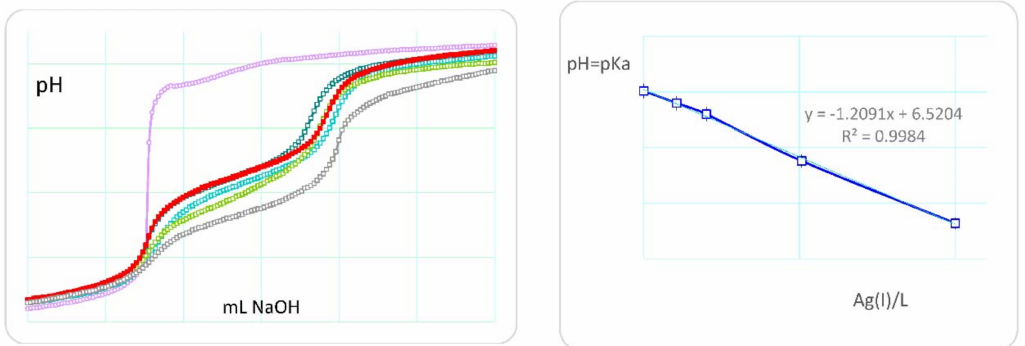
Figure 2. ( Left ) potentiometric titration curves of monomer MHist (L) in the absence (red filled) and in the presence (open circles) of increasing amount of Ag(I) ions. The violet line is only silver(I) ions. ( Right ) plot of the pH = pKa values in relation to the Ag(I)/L molar ratio. L: 0.15 mmol; Ag(I): 0.015, 0.030, 0.075, 0.15 mmol.